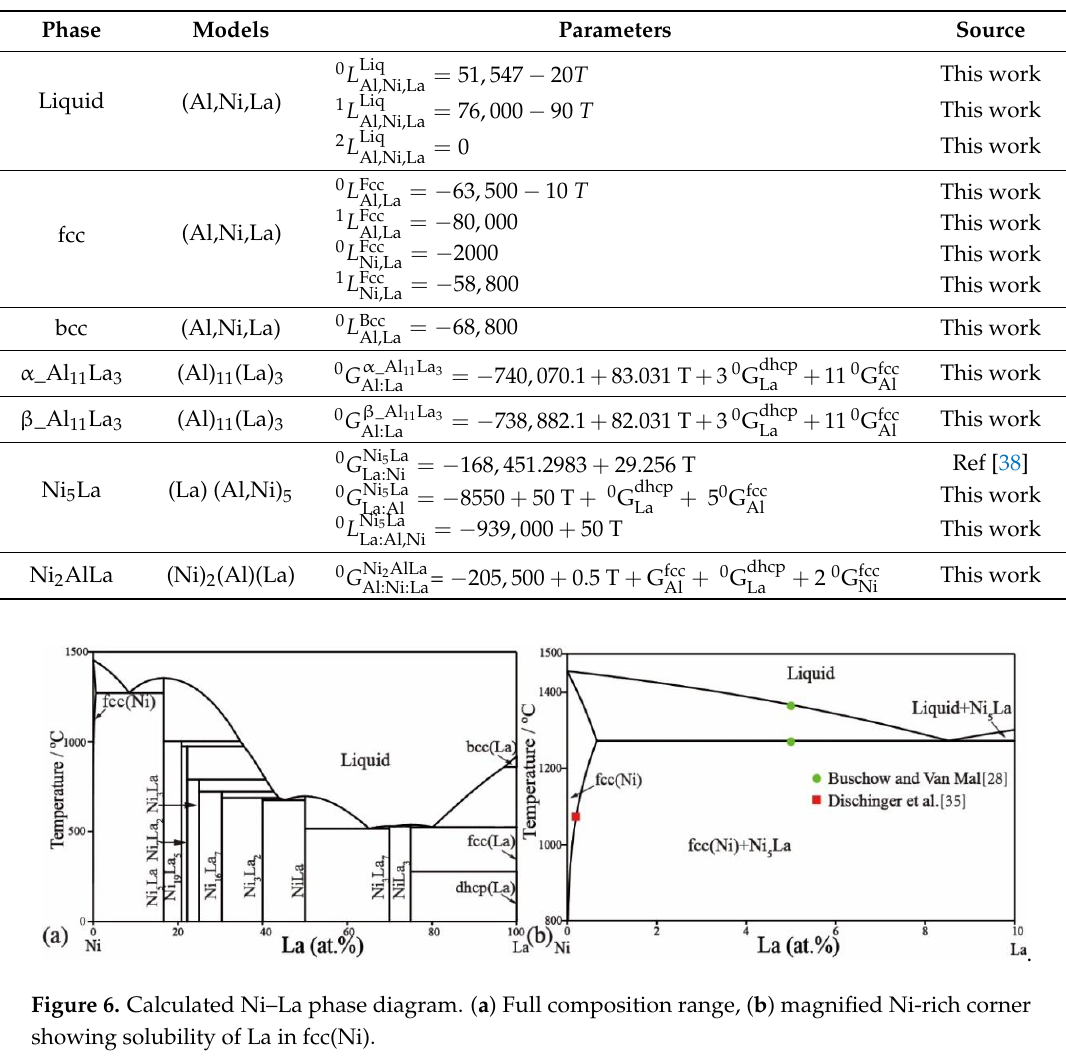
Table 4. Optimized thermodynamic parameters of the Ni–Al–La ternary system.